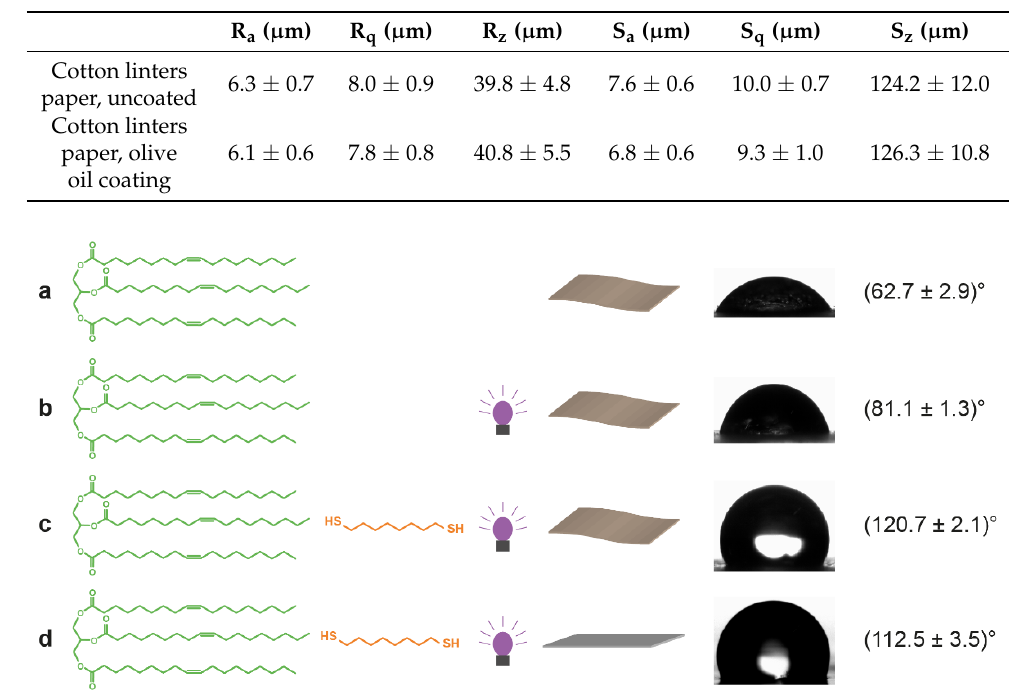
Figure 6. Static water contact angles (sessile drop) measured on ( a ) cotton linters paper coated with pure olive oil; ( b ) cotton linters paper coated with pure olive oil and submitted to UV irradiation; ( c ) cotton linters paper coated with the olive oil/thiol mixture and submitted to UV crosslinking; ( d ) glass coated with the olive oil/thiol mixture and submitted to UV crosslinking as a smooth reference substrate for comparison.